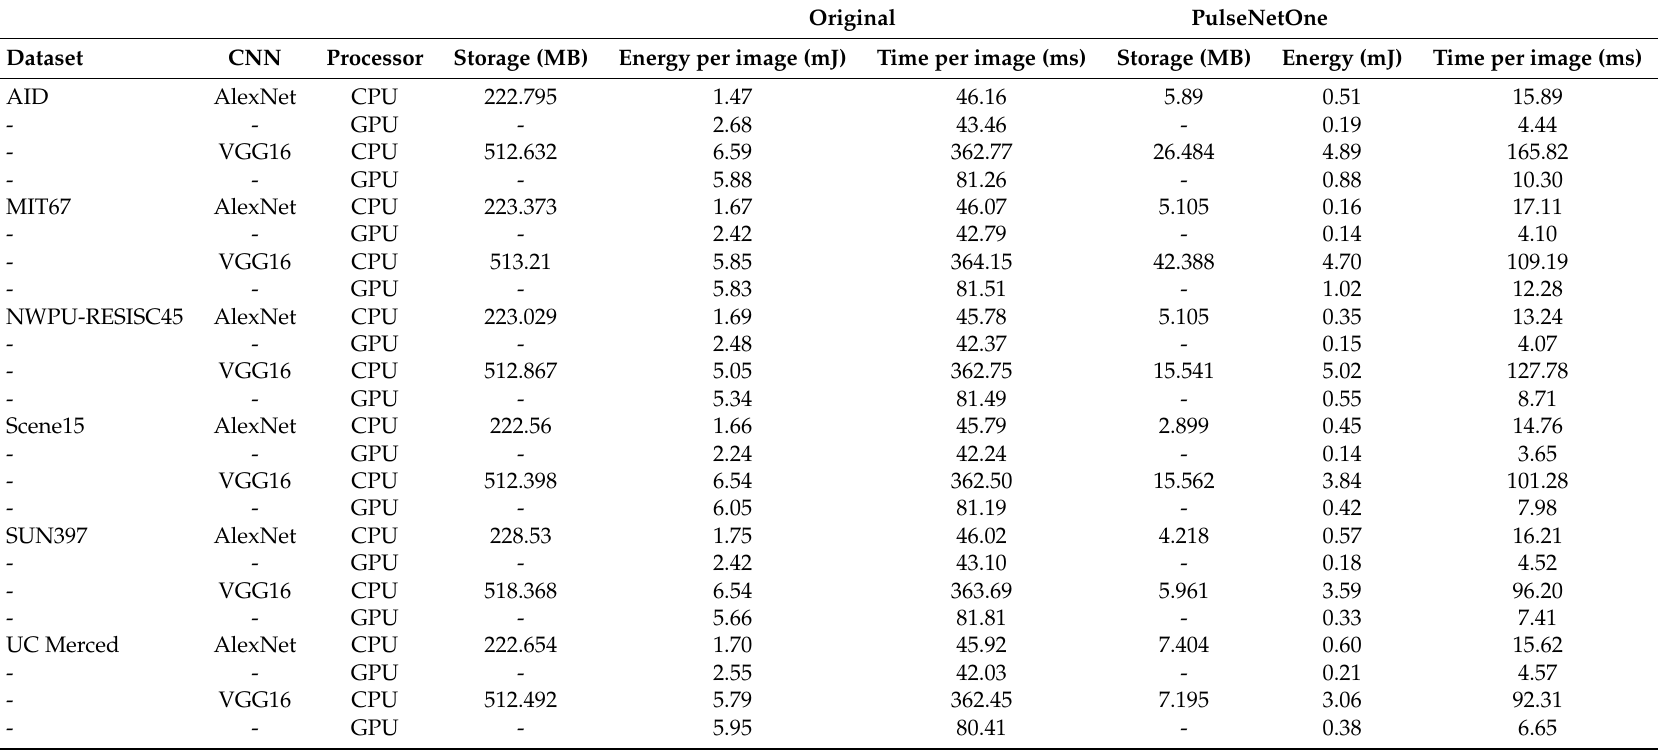
Table 14. Computational results for datasets AID, MIT67, NWPU-RESISC45, Scene15, SUN397 and UC Merced using AlexNet and VGG16. It shows the storage space each network requires, the inference speed per image and the energy consumed per image of both the original and pruned networks using a batch size of a single